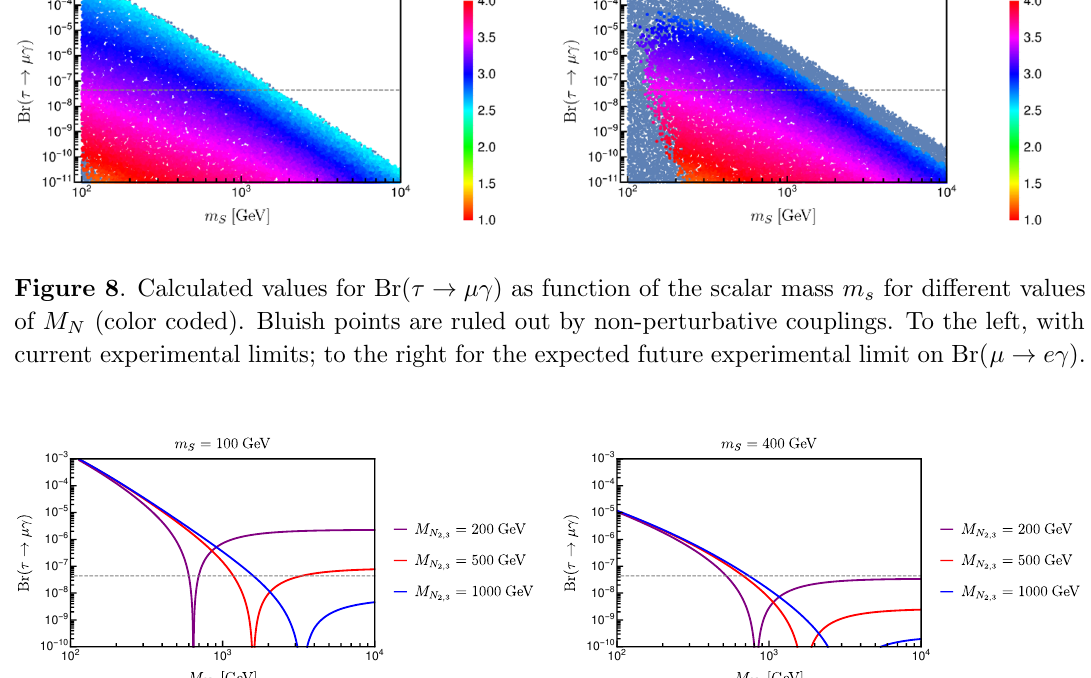
Figure 9 . Calculated values for Br( (cid:28) (cid:22)(cid:13) ) as function of the lightest right-handed neutrino ! mass M N for di(cid:11)erent choices of M N and two di(cid:11)erent scalar masses m S (left and right). The 1 2 ; 3 calculation uses for simplicity the b.f.p. for neutrino